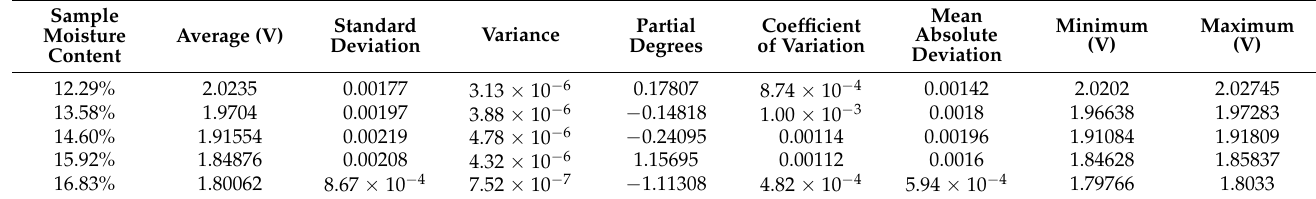
Figure 18. Sensor collection of voltage values. Table 4. Data collection and analysis